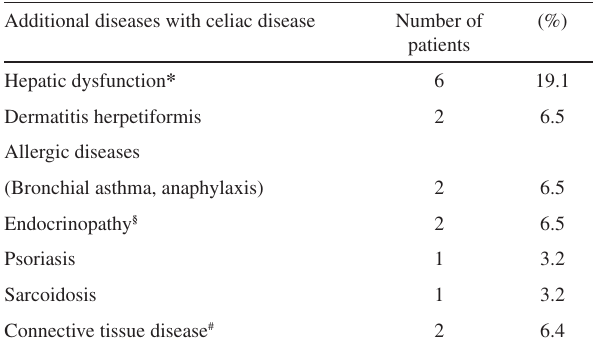
Table 4 - Frequency of other diseases in patients with celiac disease Additional diseases with celiac disease Number of